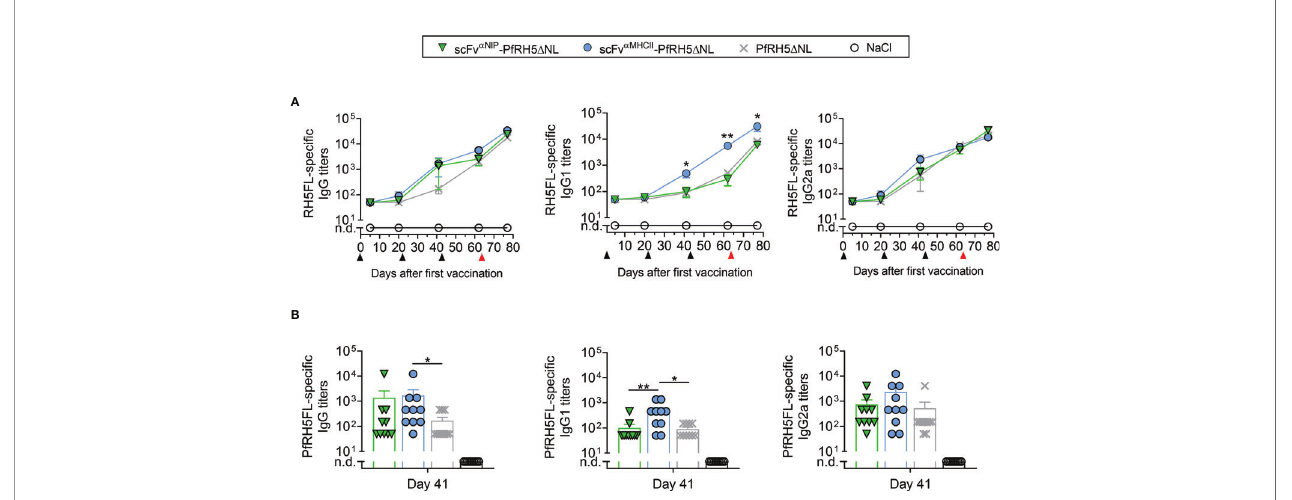
FIGURE 2 | scFv a MHCII -PfRH5 D NL DNA vaccination increased RH5FL-speci fi c IgG1 antibody responses. (A, B) BALB/c mice were vaccinated three times (day 0, 21 and 42, black arrows) with 50 µg DNA i.m./EP with scFv a MHCII -targeted or non-targeted (scFv a NIP ) vaccine plasmids containing PfRH5 D NL, the PfRH5 D NL antigen alone or NaCl as indicated. At day 63, the mice were boosted with a PfRH5FL-adenoviral vector (i.m., 1x1010 IU/mouse, red arrow) (A) Serum samples were assayed for PfRH5FL-speci fi c IgG, IgG1 and IgG2a at day 5, 20, 41, 62 and 77 in ELISA, shown as mean ± SEM. Stars indicate statistical signi fi cance between the scFv a MHCII -PfRH5 D NL group and the PfRH5 D NL antigen alone group. (B) Individual mice and mean ± SEM at day 41 are shown, n = 10/group (DNA vaccinated) or n = 5/group (AdHu5-PfRh5FL boosted), *p < 0.05, **p < 0.01, two-tailed Mann-Whitney test. n.d., not